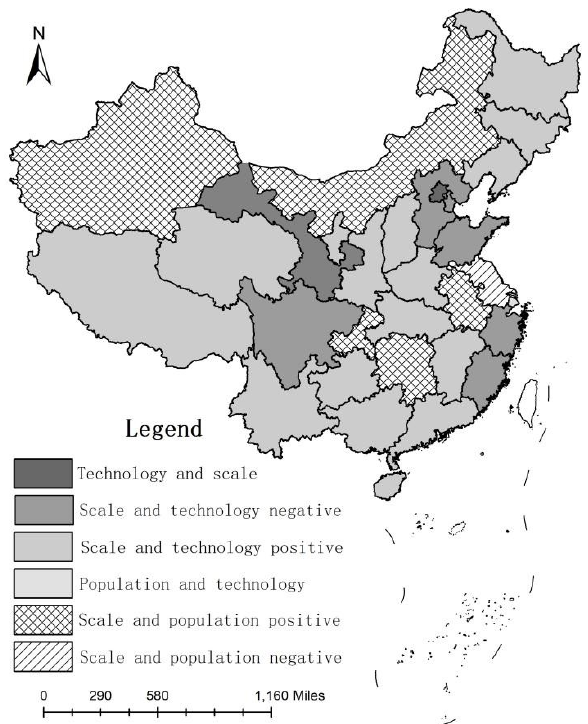
Figure 4. The spatial difference of main factors of carbon emissions from the planting industry.